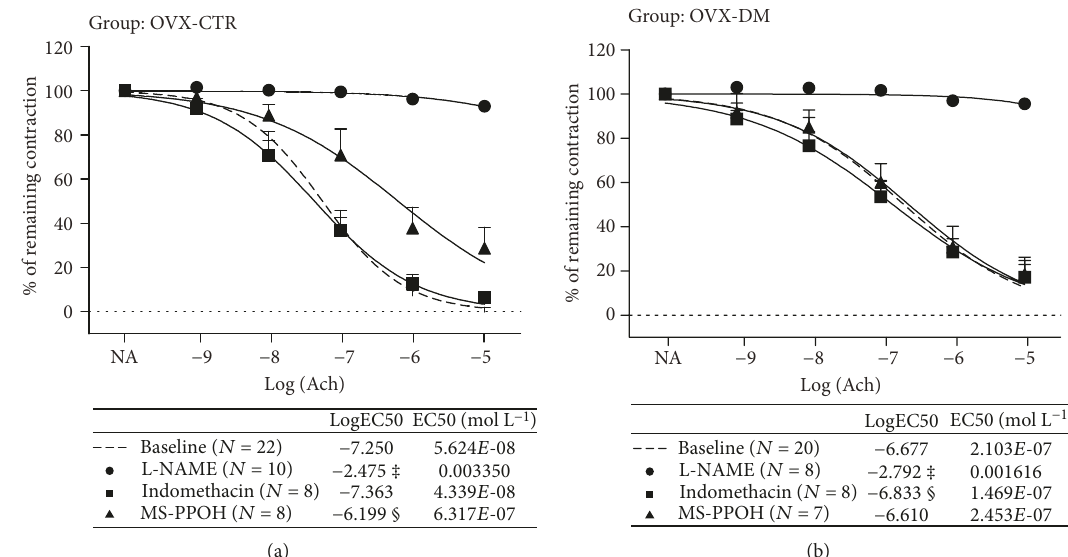
Figure 3: Mechanisms of the acetylcholine-induced relaxation (AChIR) response of isolated rat aorta rings in OVX-CTR and OVX-DM rats. (a) and (b) present the relaxation of isolated aortic rings in response to ACh (presented as log [ACh] of ACh concentration (10 -9 to 10 -5 M)) in the OVX-CTR (a) and OVX-DM (b) groups of rats. The presence of L-NAME and MS-PPOH signi fi cantly reduced the AChIR of isolated rat aortic rings in the OVX-CTR group (a), and only the presence of L-NAME signi fi cantly reduced the AChIR in the OVX-DM group (b) of rats. Indomethacin administration did not have any signi fi cant e ff ects on AChIR in both the OVX-CTR (a) and OVX-DM (b) groups of rats. Data were compared by two-way ANOVA and Bonferroni post hoc tests. Sensitivity to ACh in the presence of L-NAME and MS-PPOH was signi fi cantly decreased compared to the basic response or response to ACh in the presence of Indomethacin in OVX-CTR, while in OVX- DM, sensitivity to ACh in the presence of L-NAME was signi fi cantly decreased compared to the basic response or response to ACh in the presence of Indomethacin or MS-PPOH. LogEC50 values were compared by one-way ANOVA followed by Holm-Sidak pairwise multiple comparison. Statistically signi fi cant ( P < 0 05 ) AChIR in the presence of L-NAME ( ∗ ) or MS-PPOH ( † ) compared to the baseline ACh response. P < 0 05 : ‡ L-NAME vs. baseline, Indomethacin, and MS-PPOH; § MS-PPOH vs. baseline and Indomethacin.